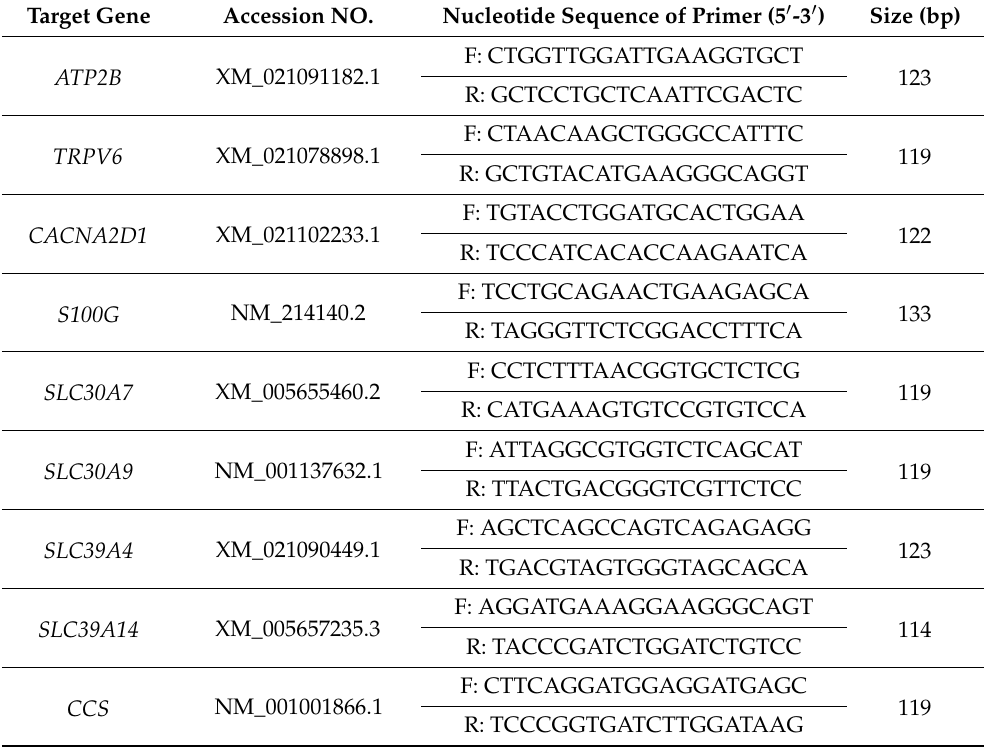
Table 2. Primers used for RT-qPCR. Target Gene Accession